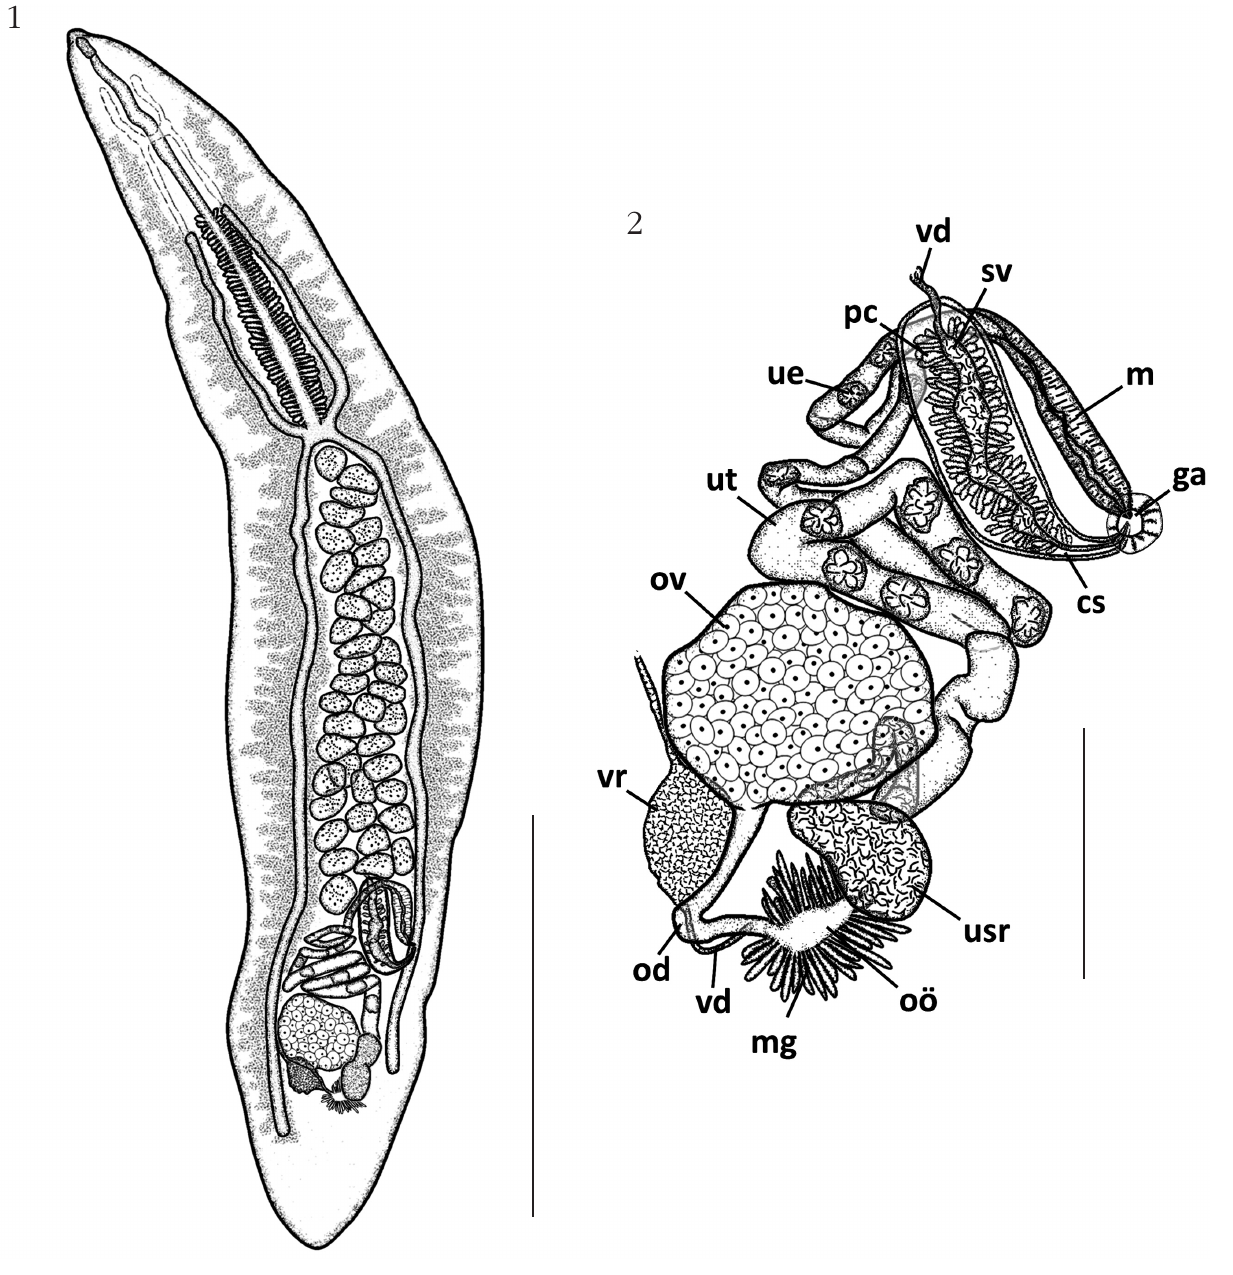
Figs 1, 2. – Aporocotyle mariachristinae n. sp. from Genypterus blacodes : 1, whole worm, holotype, ventral view; 2, reproductive organs of the holotype, ventral view. Scale bars: Fig. 1: 1,000 μ m; Fig. 2: 200 μ m. Abbreviations: vd, vas deferens; sv, seminal vesicle; pc, prostatic cells; ue, uterine egg; m, metraterm; ut, uterus; ga, genital atrium; ov, ovary; cs, cirrus sac; vr, vitelline reservoir; usr, uterine seminal receptacle; od, oviduct; vd, vitelloduct; oö, oötype; mg, Mehlis’